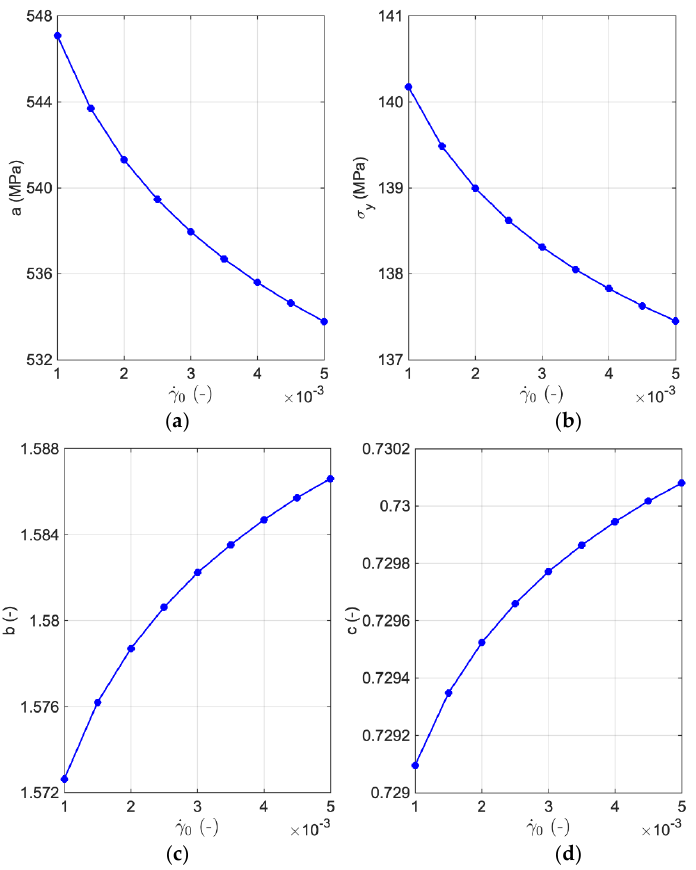
Figure 12. Variation of hardening parameters with change in γ ̇